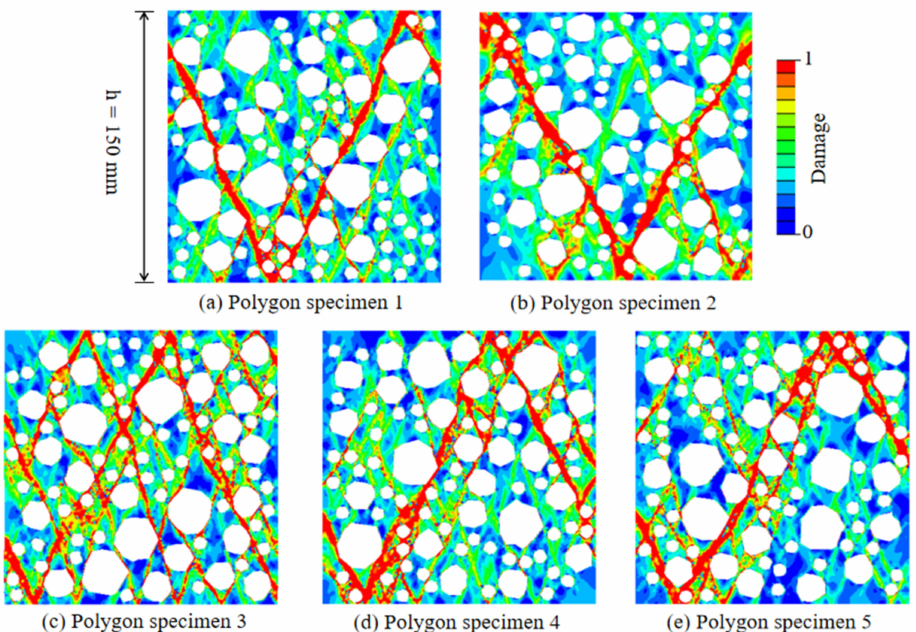
Figure 11. The failure patterns of RAC under different random distribution of RCA.